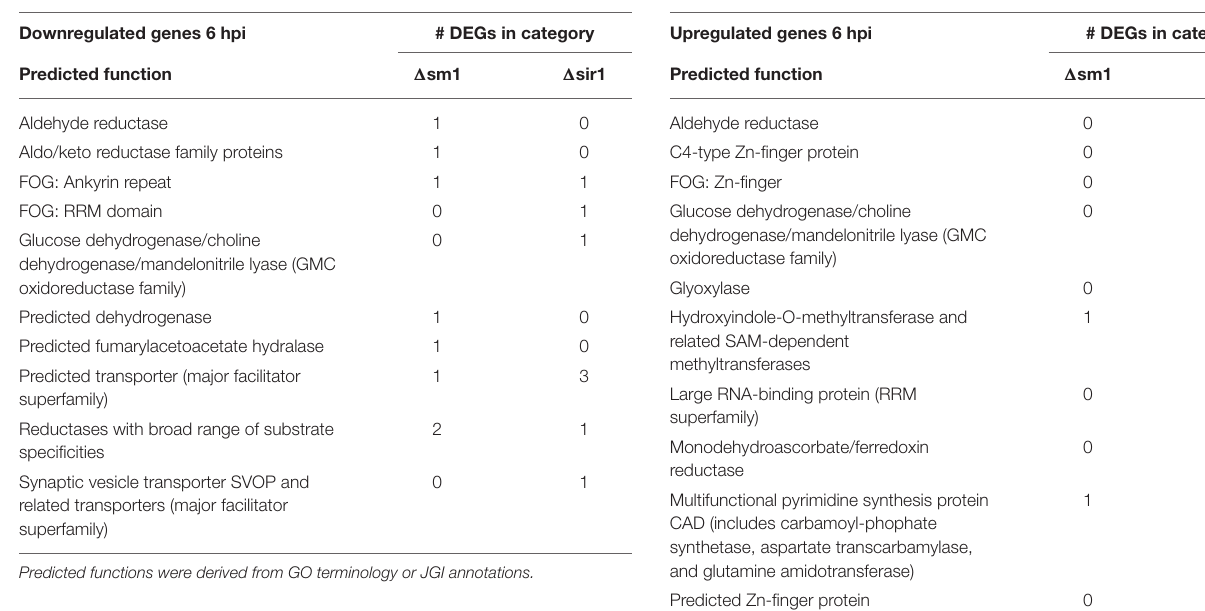
TABLE 3 | Upregulated genes with general function KOGG annotation in 1 sm1 or 1 sir1 at 6